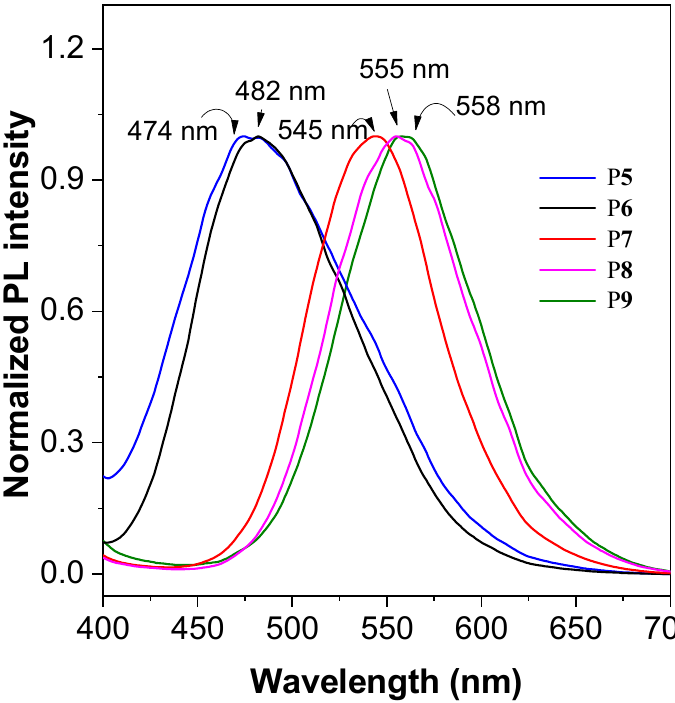
Figure 5. PL spectra of P 7 , P 8 , P 9 , P 10 , and P 11 powders. λ ex = 375 nm. On the other hand, PTMSDPA shows a typical ACQ behavior (Figure S9). The fluo- rescence intensity decreased with the increase of water fraction, which is similar to the luminescence behavior of most diphenyl acetylene derivatives [21–25]. According to the above results, a series of copolymers containing different lengths of PTMSDPA can be obtained by controlling the proportion of the two monomers and the reaction time. We can not only regulate the luminescence color from blue–purple to orange–red, but we can also adjust the luminescent behavior from ACQ of the homopolymer PTMSDPA to AIE of the copolymer.